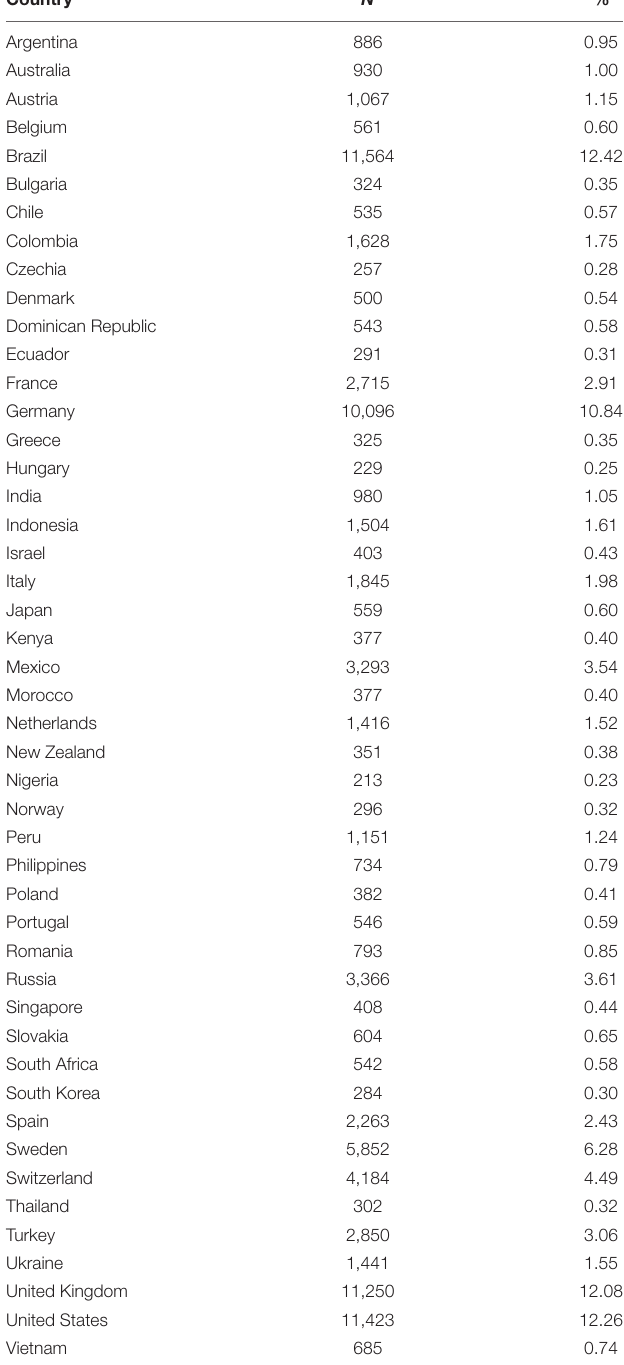
TABLE 1 | Overview of the countries in the